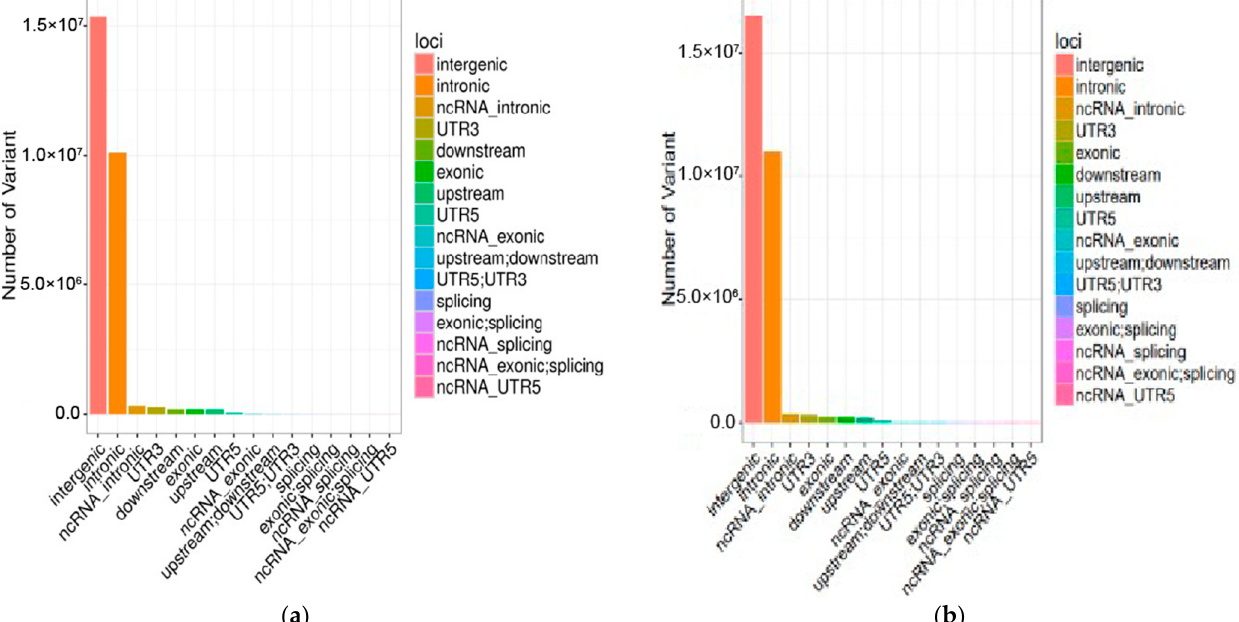
Figure 2. The statistical map of genetic variation locations of Anqing six-end-white pigs ( a ) and Asian Wild Boar ( b ).